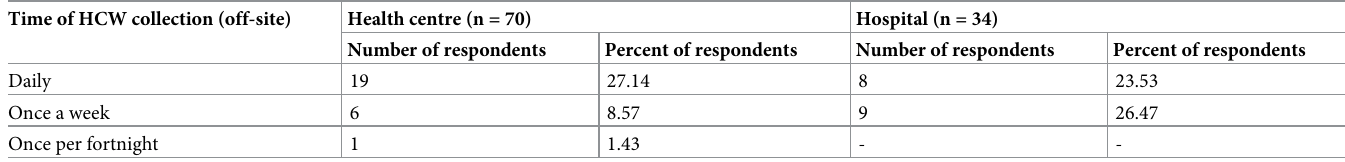
Table 10. Managers response to frequency of HCW collection by off-site authorities in the study health facilities, Addis Ababa City Administration, February 2018. Time of HCW collection